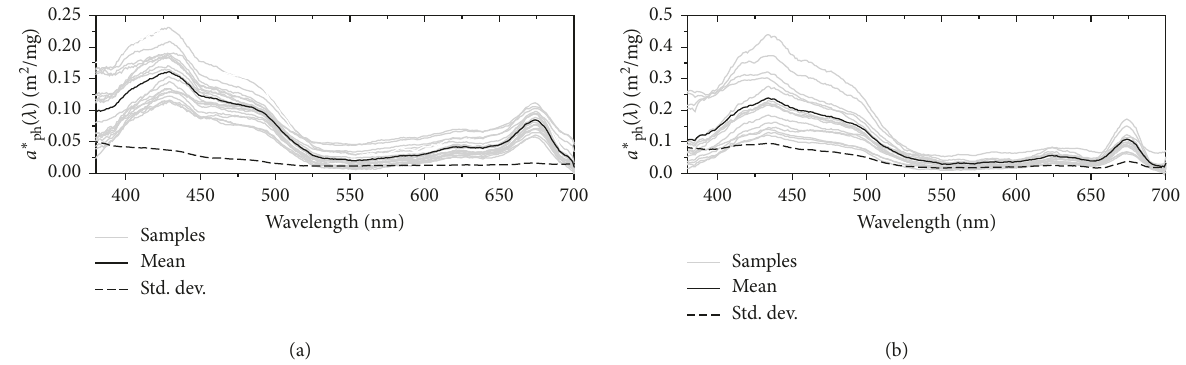
Figure 6: Phytoplankton specific absorption spectral curves in July (a) and September